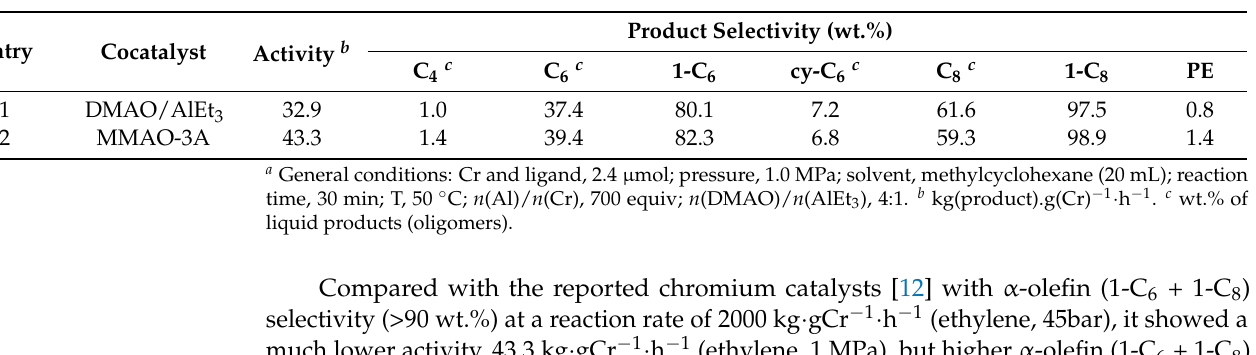
Table 8. The effect of cocatalyst on the catalytic performance of the L4-based catalyst a